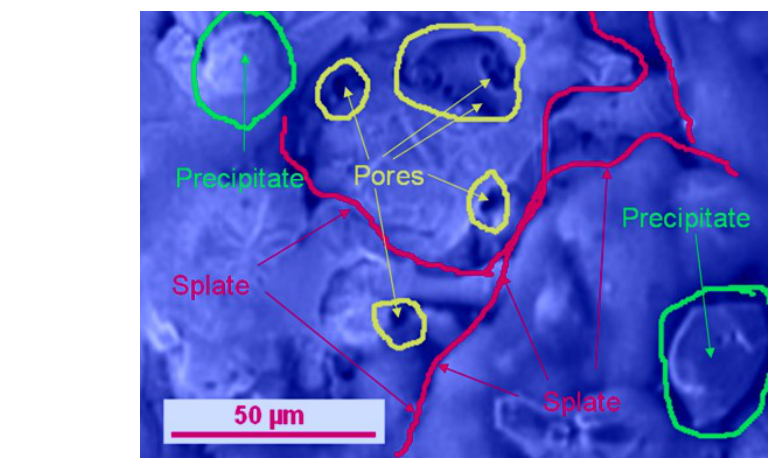
Figure 4 – (SEM) Surface morphology of the Cu10wt.%Al coating Рис . 4 – (SEM) Морфология поверхности Cu10 вес .%Al покрытия Slika 4 – (SEM) Morfologija površine Cu10tež.%Al